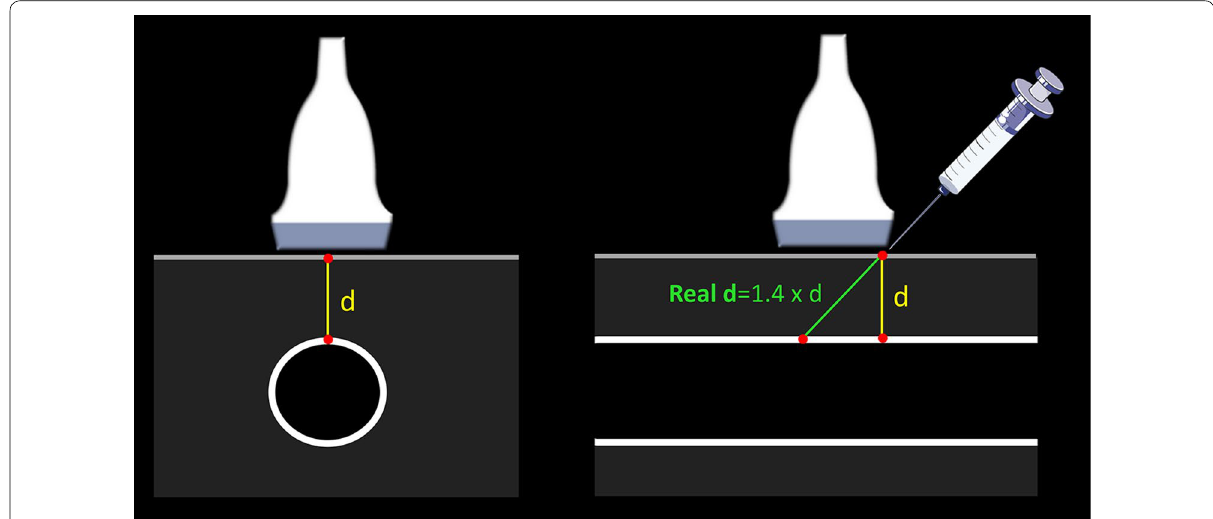
Fig. 6 Explaining the distance from skin to vessel in ultrasound-guided cannulation. While this distance ( d ) is estimated in the short axis, the real distance to reach the vein depends on the insertion angle. Assuming a 45° insertion angle, this real distance is equal to d multiplied by 1.4. Of note, the real distance decreases with sloped insertions, and increases using shallower insertions